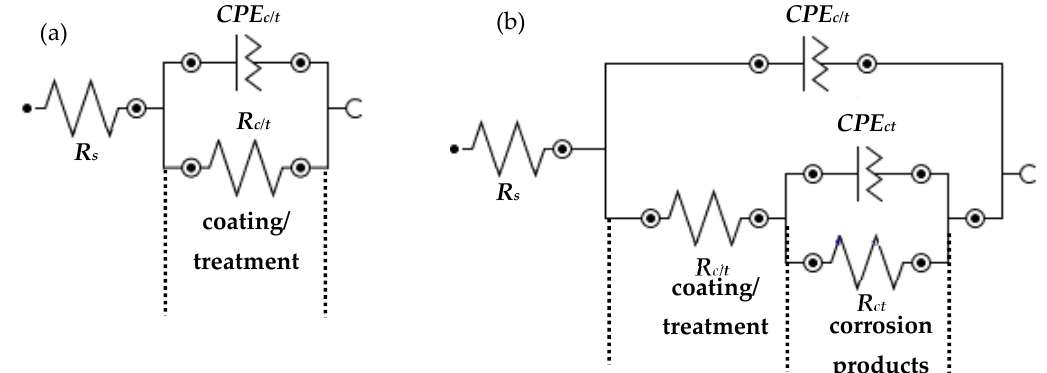
Figure 7. Electrical equivalent circuits (EEC) of ( a ) SPCN1 for 1 h and 11 days and SPCN2 for 1 h and ( b ) AC from 1 h to 89 days, SPCN1 for 41 and 89 days, SPCN2 from 11 to 89 days, and SPCN3 from 1 h to 89 days. Table 3. Electrochemical parameters after fitting of electrochemical impedance spectroscopy (EIS) plots in appropriate EECs at different durations of exposure in 3.5 wt.% NaCl solution.